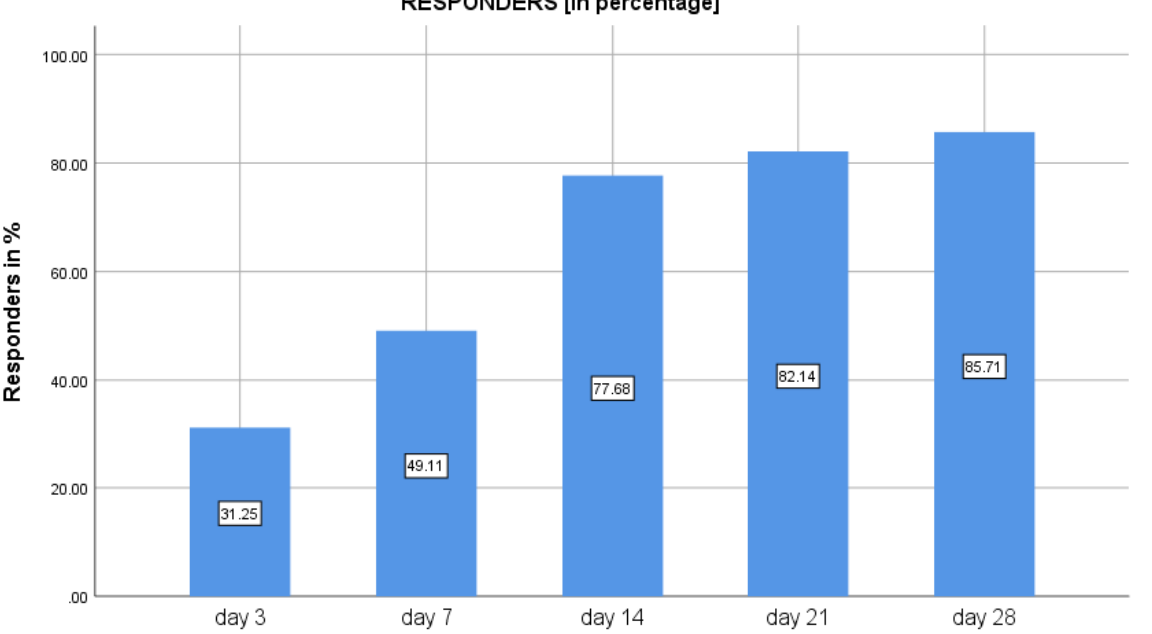
Figure 2. Percentage of responders with 50% reduction in crying time following use of Lactobacillus reuteri DSM 17938 in infantile colic.